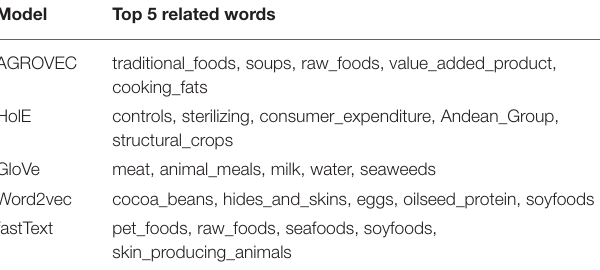
TABLE 2 | Top 5 related words for the concept